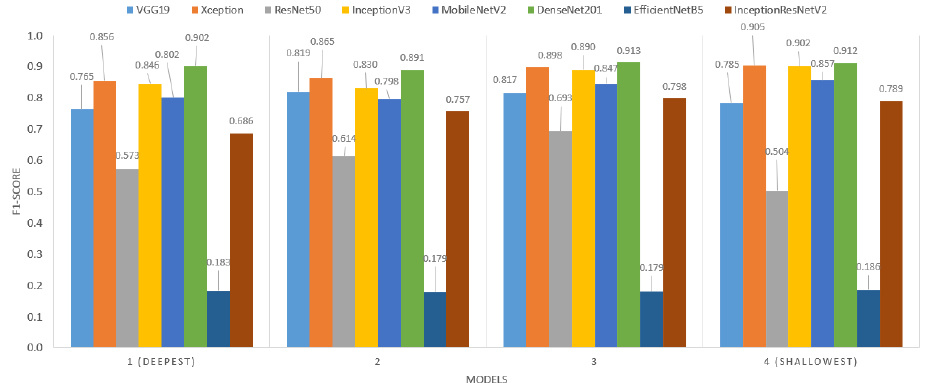
Figure 9. Summary of evaluation results by the last layer transfered, in terms of